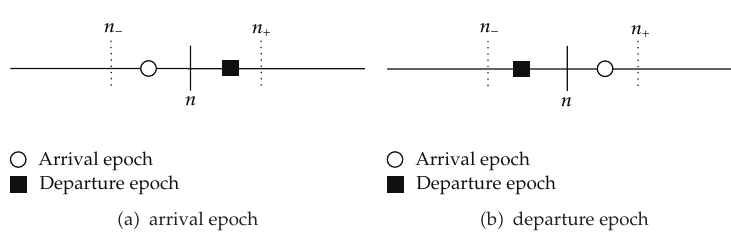
Figure 1: Time epochs for the LAS and the EAS.